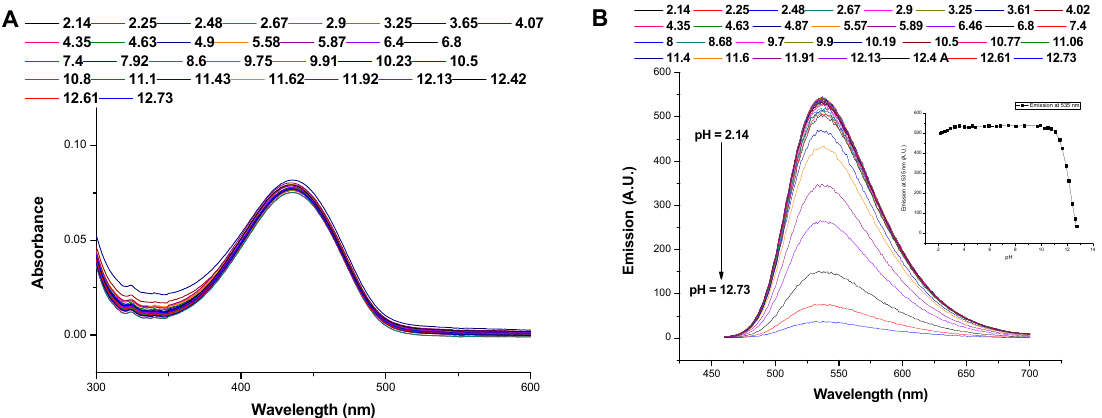
Figure 4. Influence of pH on ( A ) the absorption spectrum ( B ) the emission spectrum and on the